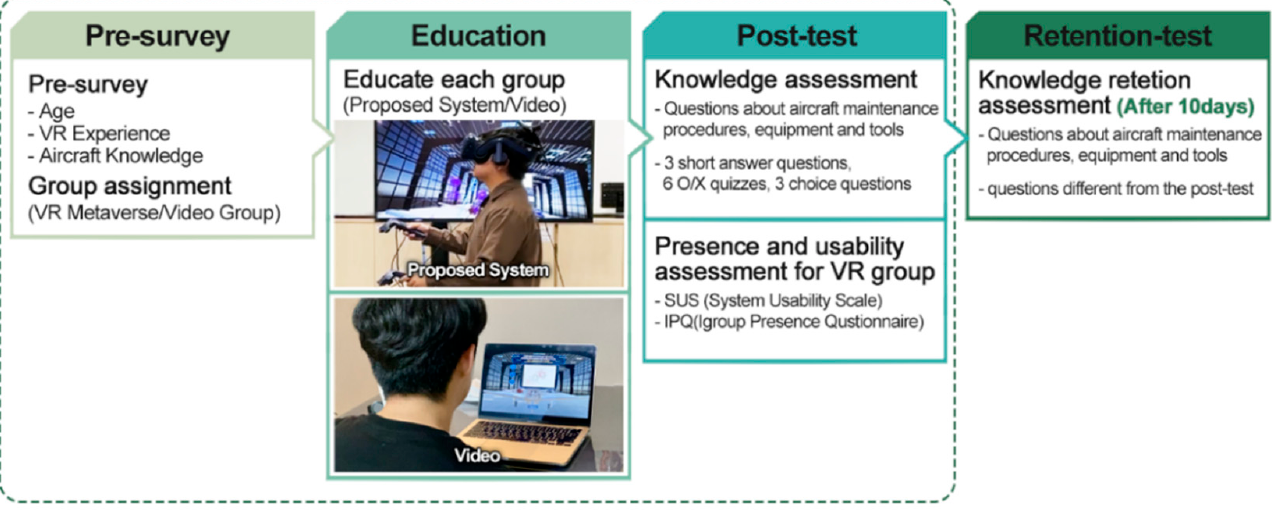
Figure 7. Experimental procedure.